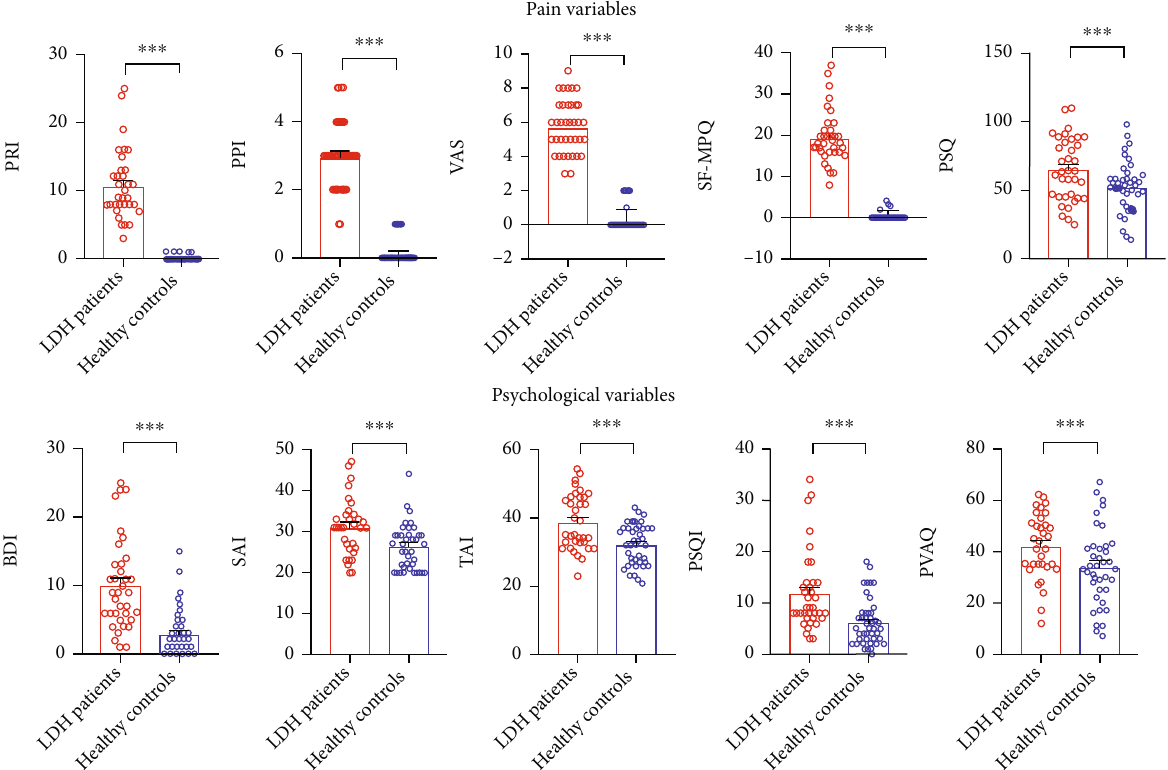
Figure 1: Comparison of pain intensities (i.e., PRI, PPI, VAS, and SF-MPQ), pain sensitivity (PSQ), and psychological variables (i.e., BDI, SAI, TAI, PSQI, and PVAQ) between LDH patients and HCs. (a) Pain intensity (i.e., PRI, PPI, VAS, and SF-MPQ) and pain sensitivity ratings (PSQ) were signi fi cantly larger in LDH patients than in HCs. PRI: a pain rating index; PPI: a present pain intensity; VAS: 10 cm visual analogue scale; SF-MPQ: short form of the McGill Pain Questionnaire; PSQ: pain sensitivity questionnaire. (b) Psychophysical variables (i.e., BDI, SAI, TAI, PSQI, and PVAQ) were signi fi cantly larger in LDH patients than in HCs. BDI: Beck-Depression Inventory; SAI: state-anxiety index; TAI: trait-anxiety index; PSQI: Pittsburgh sleep quality index; PVAQ: pain vigilance and awareness questionnaire; LDH: lumbar disc